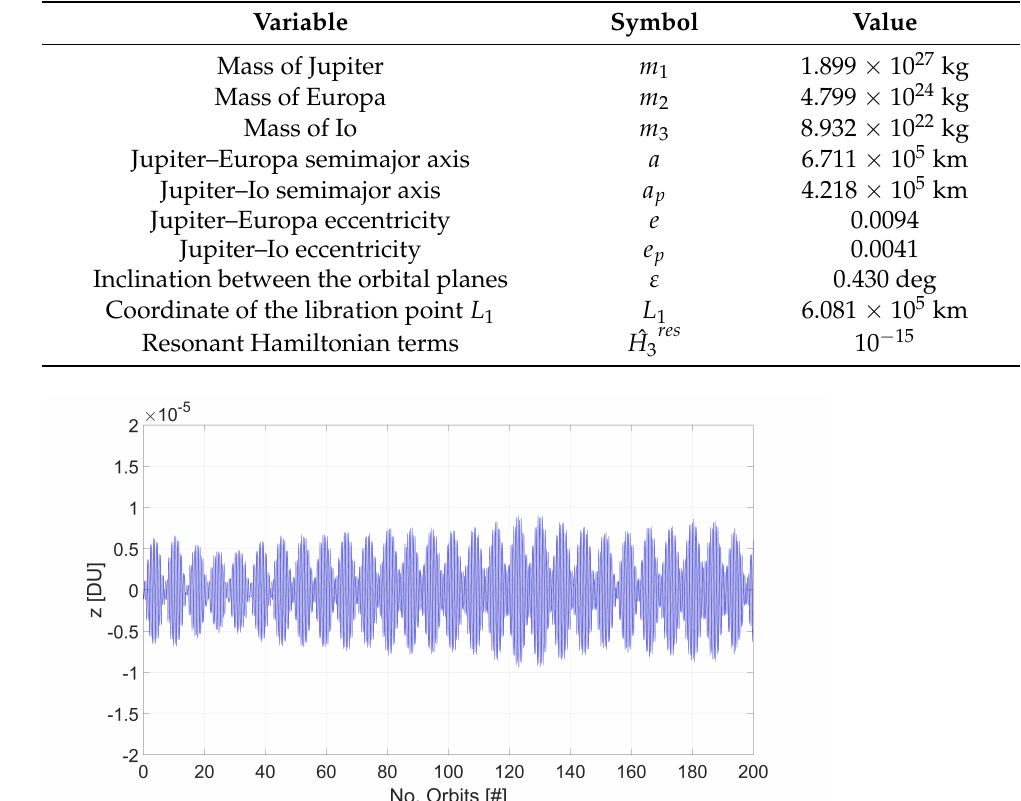
Figure 4. Behavior of the vertical oscillator associated to a stationary point. The solution is compared to the one obtained ignoring the order three terms, corre- sponding to the state x 1 = L 1 , x 2 = 0, x 3 = − 10 − 10 , y 1 = 0, y 2 = 0 and y 3 = 0. The time behaviour of the oscillations is represented in Figure 5, showing that the orbital perturba- tion of Io produces an increase of the amplitude up to ± 2.9 × 10 − 4 DU in the time interval considered. Differently, the amplitude of oscillations for the quasiperiodic orbit obtained from the stationary point never exceeds the value 10 − 5 DU.